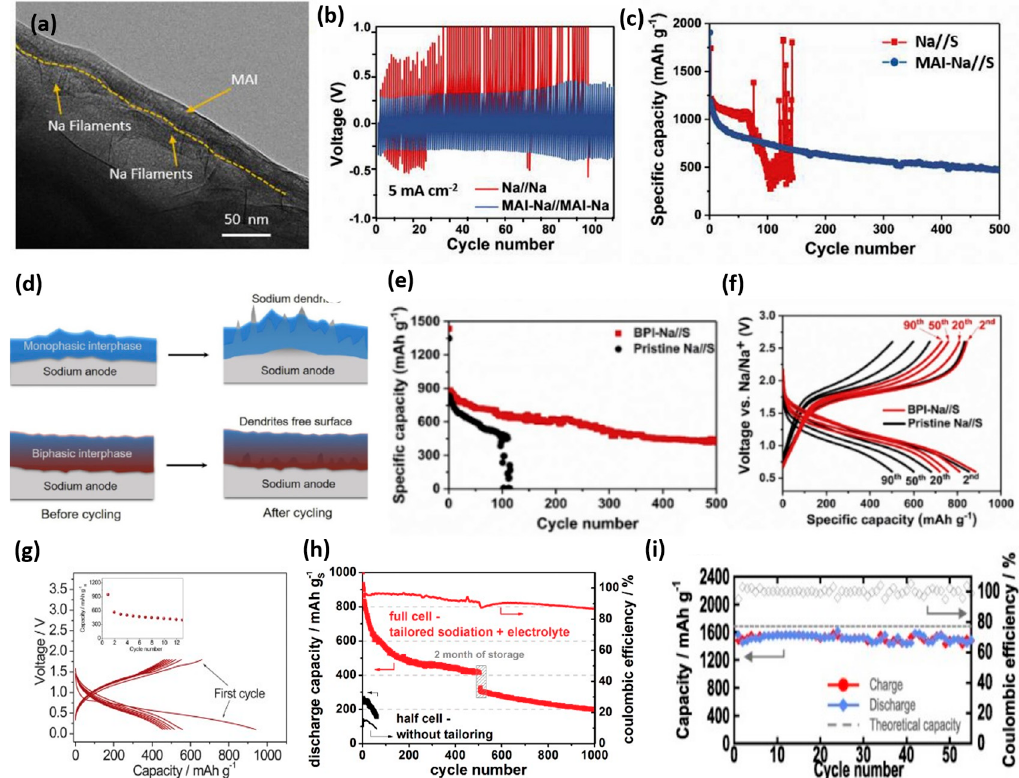
Figure 10. ( a ) Cryo-TEM micrographs of the as-deposited Na with MAI, ( b ) galvanostatic stripping/plating test of Na symmetric cells with and without MAI at 5 mA cm − 2 , and ( c ) cycle performance of RT − NaSBs with and without MAI. Reproduced with permission [158]. Copyright 2020, Elsevier. ( d ) Schematic illustration of the e ff ect of cycling on Na anode with and without BPI ( e ) cycle performance and ( f ) voltage pro fi les of RT − NaSBs with and without BPI. Reproduced with permission [159]. Copyright 2020, Cell Press. Voltage profiles of ( g ) Na–Sn–C/TEGDME 4 - NaCF 3 SO 3 /HCS–S full cell. Reproduced with permission [119]. Copyright 2013, Royal Society of Chemistry. ( h ) Comparative cycle performance of RT-NaS cells with 1 M NaClO 4 0.2 M Na 2 S/P 2 S 5 in TEGDME|Na anode (black lines) and a hard carbon anode sodiated in 1 M NaPF 6 in DEC: EC + FEC (6:4 + 1% vol.) (red lines). Reproduced with permission [124]. Copyright 2016, Wiley. ( i ) ASSB using an S-MSP20-Na 3 SbS 4 composite electrode. Reproduced with permission [138].